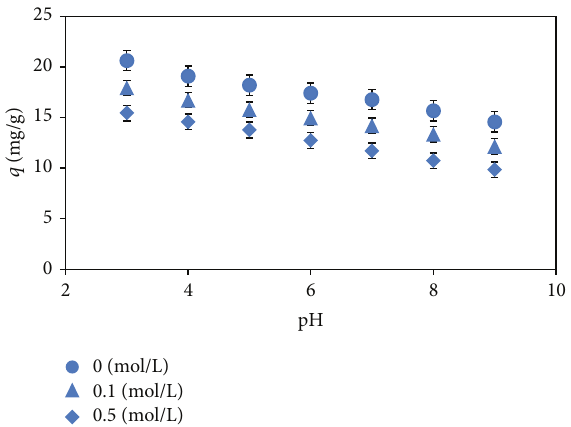
Figure 1: Effect of pH and ionic strength ( 𝑚 : 1g L −1 , 𝐶 𝑇 : 293